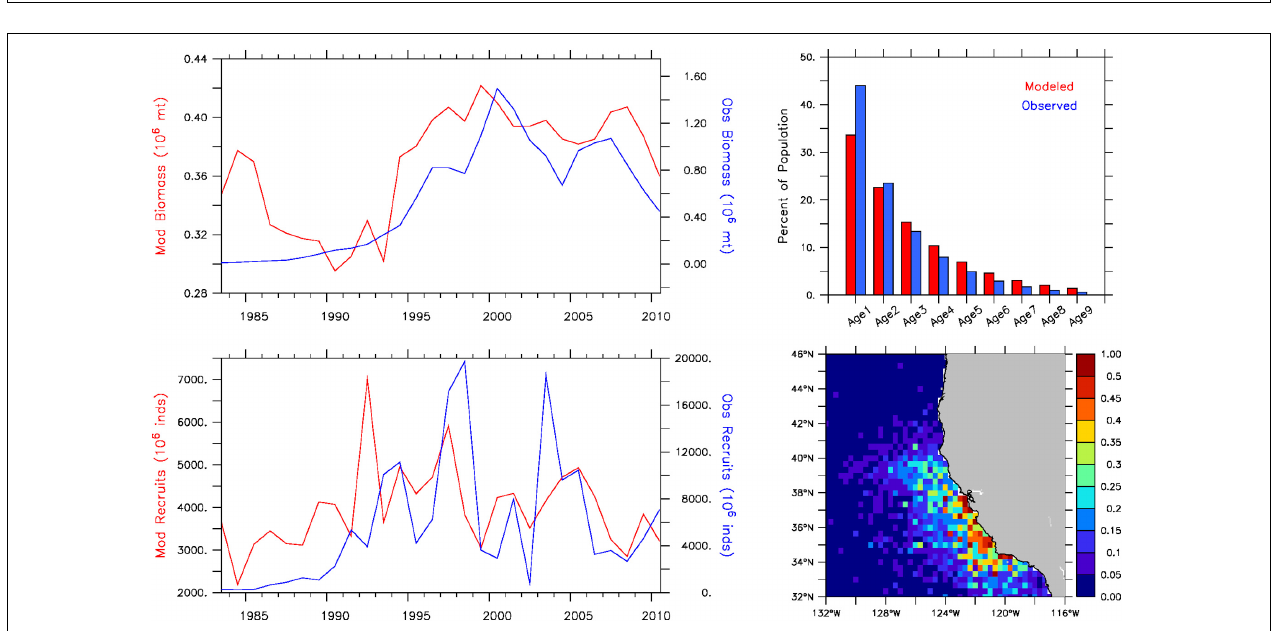
FIGURE 2 | Historical sardine population dynamics from the IBM for 1983–2010. Top left: simulated (red) and observed (blue) spawning stock biomass (adults age-2 and older) (10 3 metric tons). Top right: simulated (red) and observed (blue) age-class distribution (percent of population). Bottom left: simulated (red) and observed (blue) recruitment (millions of individuals). Bottom right: Annual mean simulated egg distribution (percent of total production contained in each grid cell). Observed values are from Hill et al. (2010) stock assessment estimates.